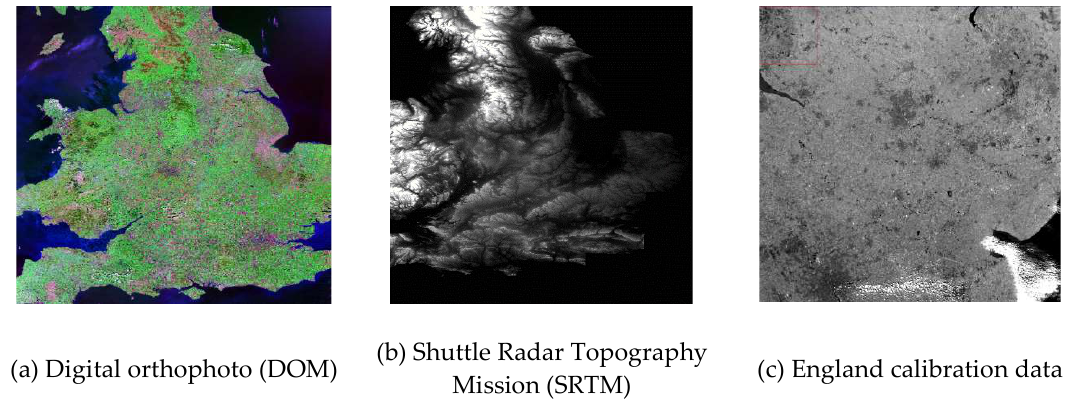
Figure 4. England regional control and calibration data.